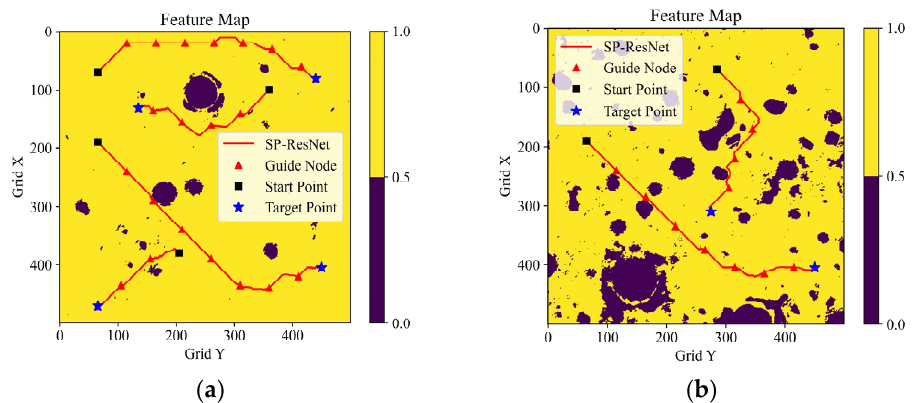
Figure 10. Path planning tests on real lunar terrains: ( a ) planning results with Map 1 and ( b ) planning results with Map 2.